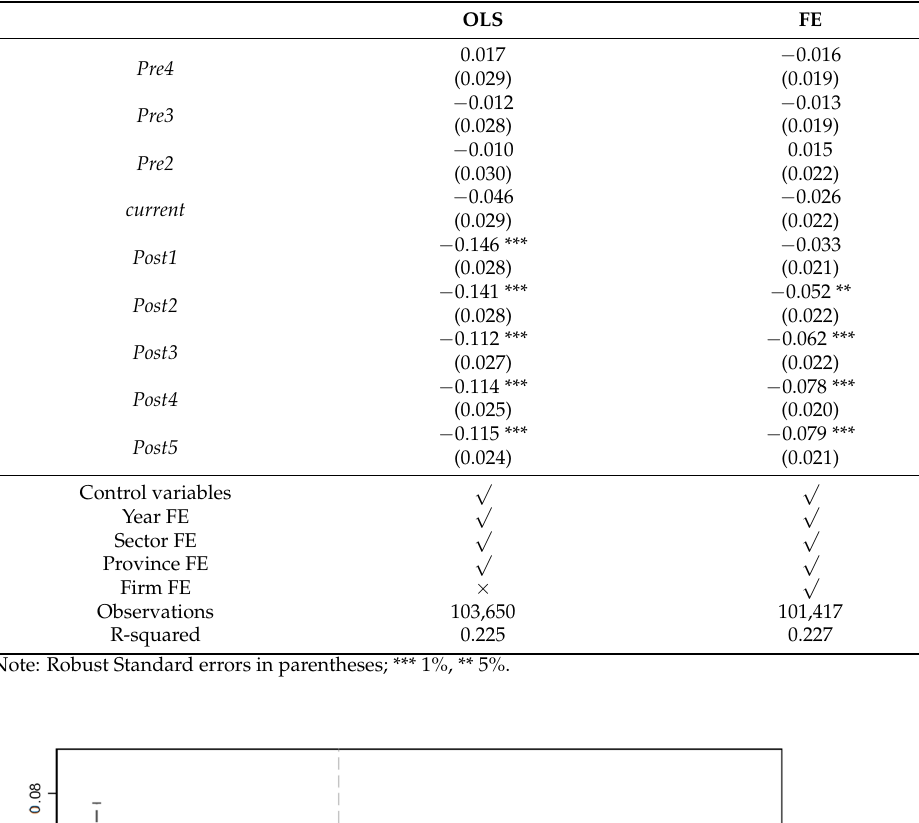
Table 5. Parallel trend test and dynamic policy effect analysis.